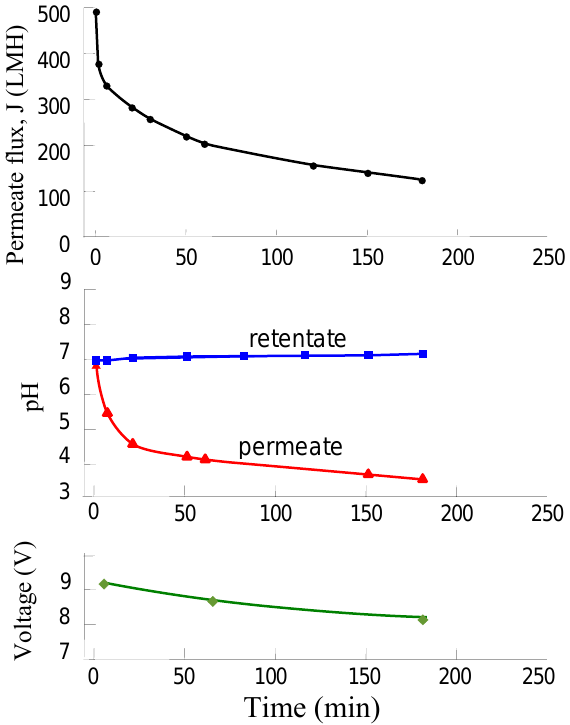
Figure 8. The pH divergence of the permeate and retentate in a continuous run of EMF, in which the membrane worked as an anode (Current density: 53 A/m 2 ; Membrane pore